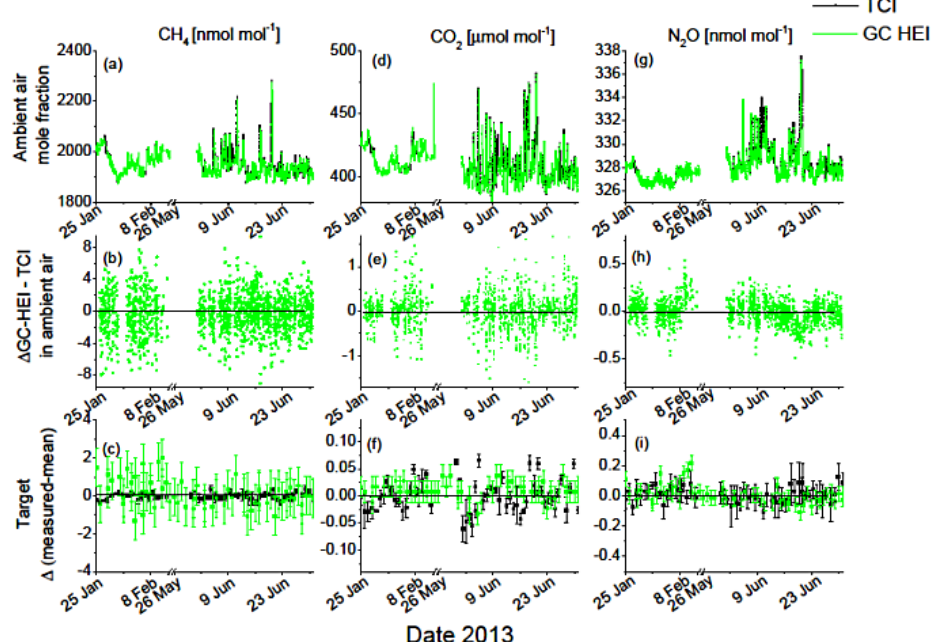
Figure 4. Upper panels: mole fraction of ambient air (a) CH 4 , (d) CO 2 and (g) N 2 O during the preparing and finalizing comparison periods in Heidelberg. From 25 January 2013 until 13 February 2013, both instruments were run in parallel, but with independent intake lines. From 1 June 2013 until 1 July 2013, both instruments used the same intake line. Middle panels: differences between the GC-HEI and the TCI for (b) CH 4 , (e) CO 2 and (h) N 2 O. Lower panels: TCI and GC-HEI daily target deviation from mean for (c) CH 4 , (f) CO 2 and (i) N 2 O. Notice the interruption in the x axis from February to May 2013 where the Mace Head measurement campaign took place.